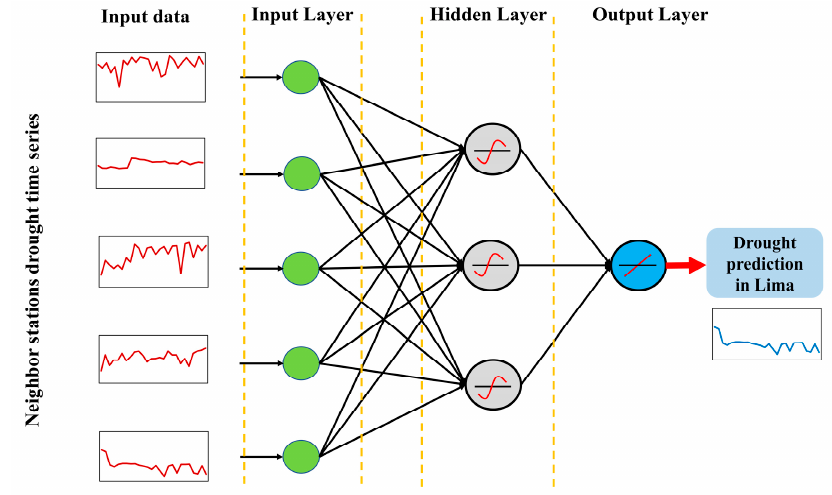
Figure 3. Schematic structure of used ANN model in the current study.